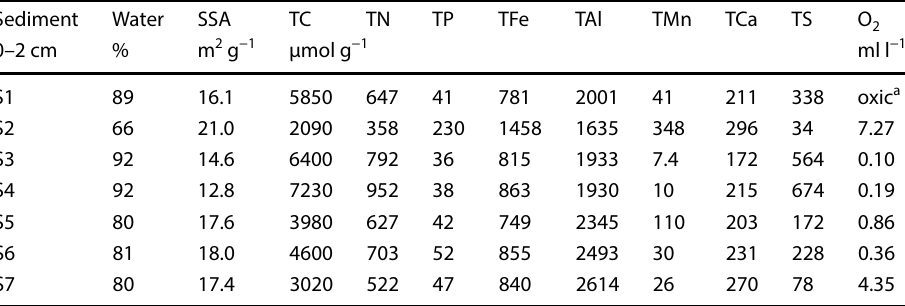
Table 2 Physico-chemical characteristics of sediments S1-S7: water content (Water), specific surface area (SSA), total (T) elements and oxygen (O ) concentration of near- 2 bottom